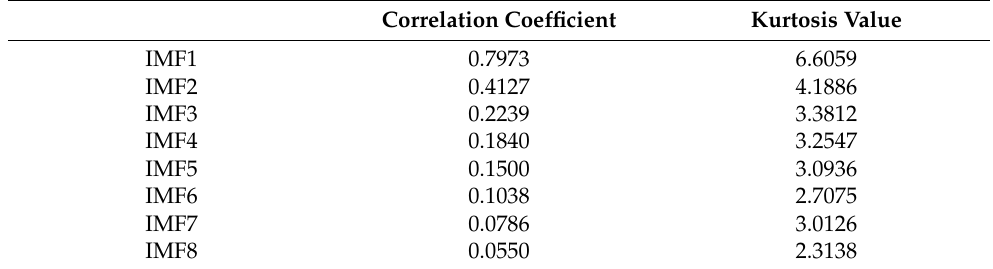
Table 6. Correlation coefficients of IMF components of simulated signals and their kurtosis indexes.